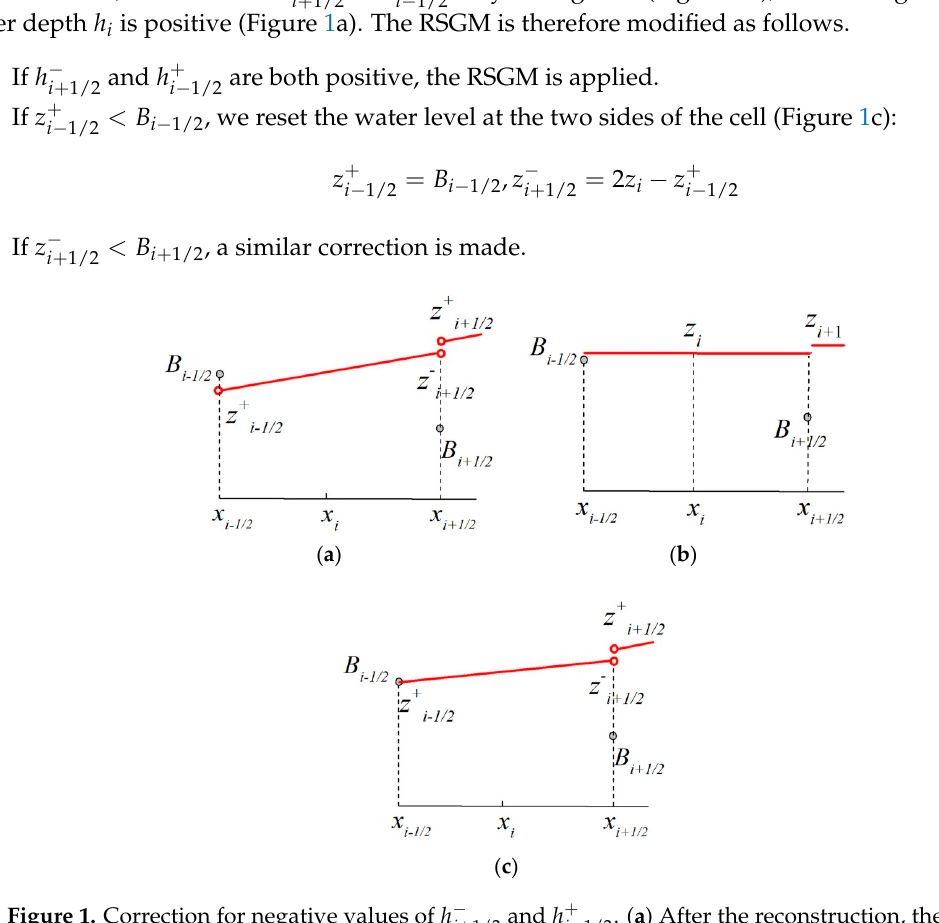
and h + . ( a ) After the reconstruction, the water i + 1/2 i − 1/2 + = B = 0. z − also needs to be i − 1/2 , h i − 1/2 i − 1/2 i + 1/2